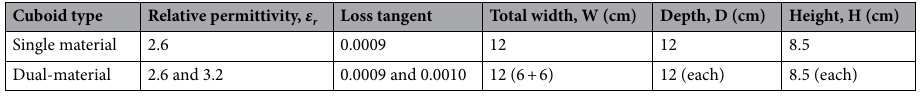
Table 1. Summary of details of the dielectric cuboids used in this study.